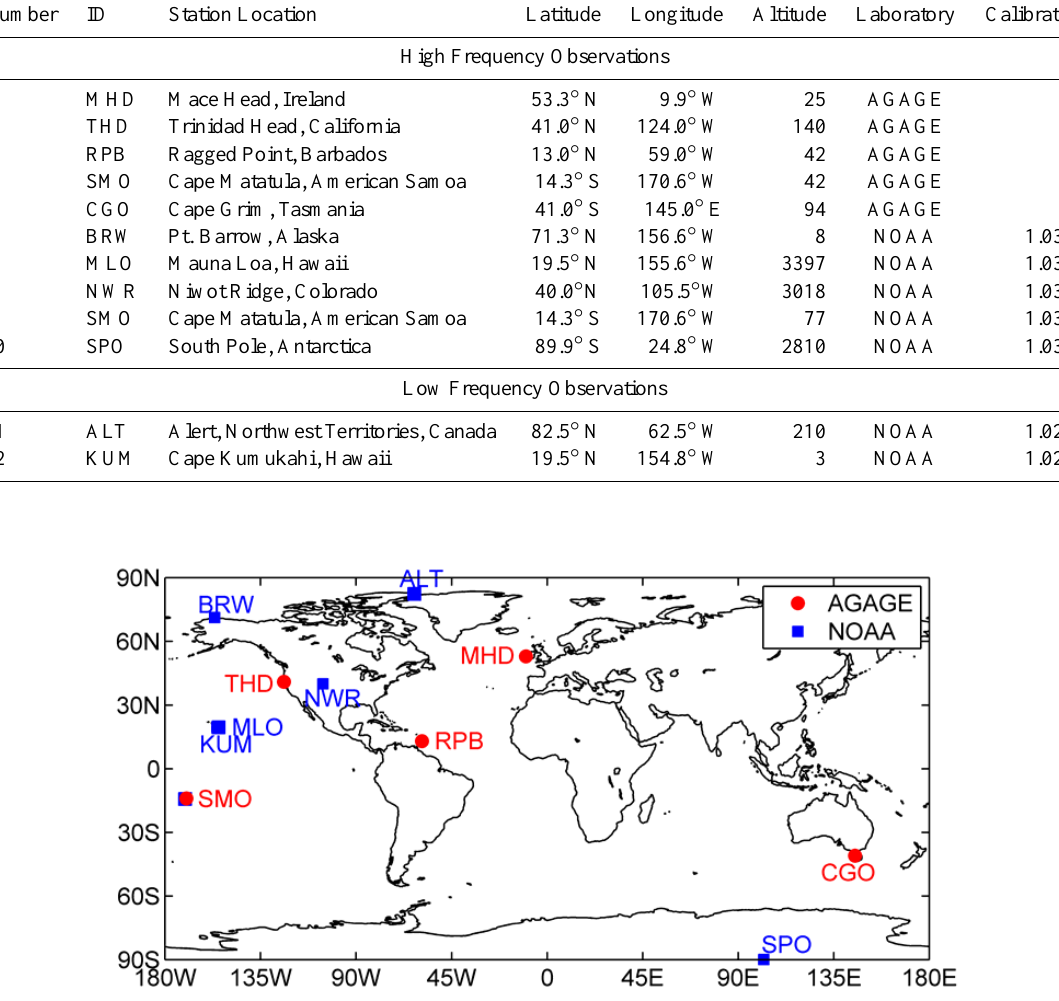
Fig. 1. Location of CCl observing sites used in the inversions (see Table 1 for station 4 abbreviations and intercalibrations).